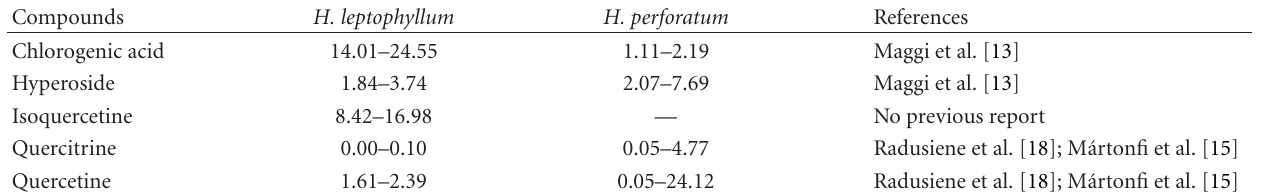
Table 2: Comparison of the content (mg/g DW) of chlorogenic acid, hyperoside, isoquercetine, quercitrine, and quercetine in Hypericum leptophyllum and Hypericum perforatum (compiled from referred